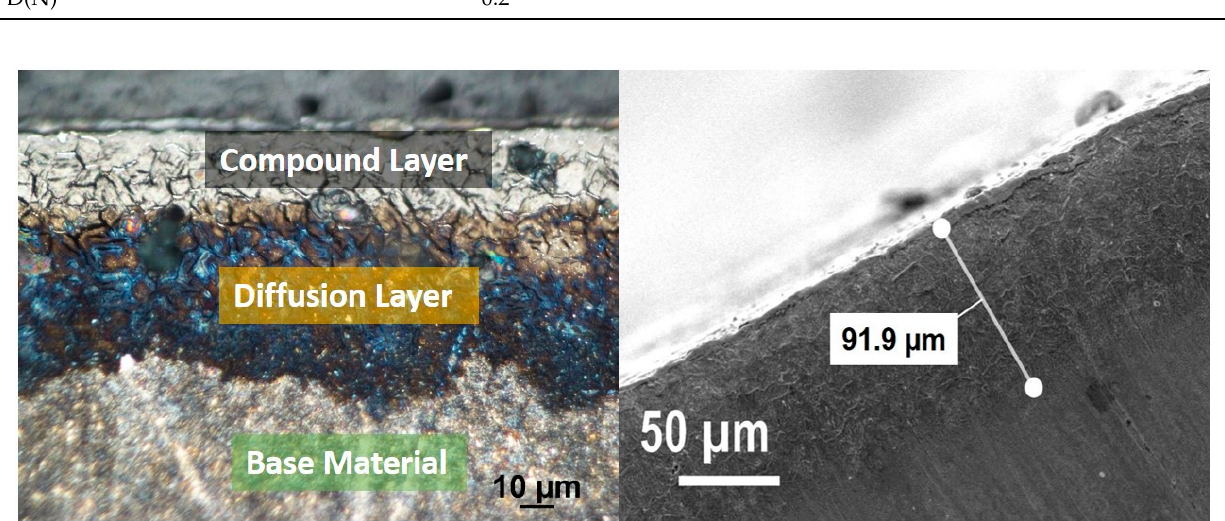
Figure 6. Optical microscope and SEM cross-section images of the nitrided layer.